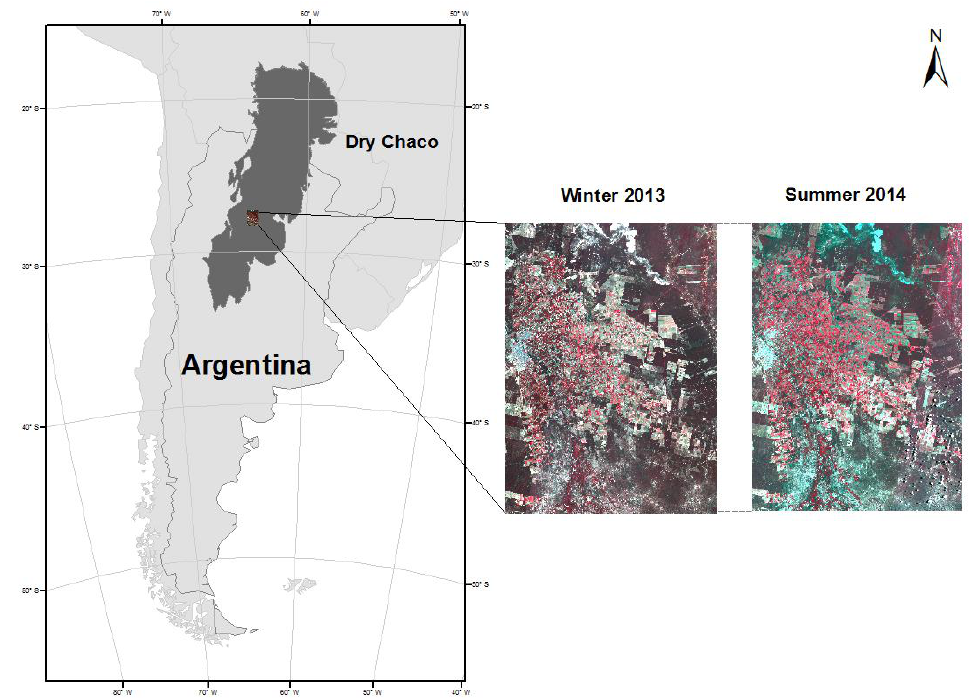
Figure 1. Location of the study area in the semiarid Chaco, province of Santiago del Estero, Argentina. The study area is depicted by the winter 2013 and summer 2014 Landsat multispectral image.